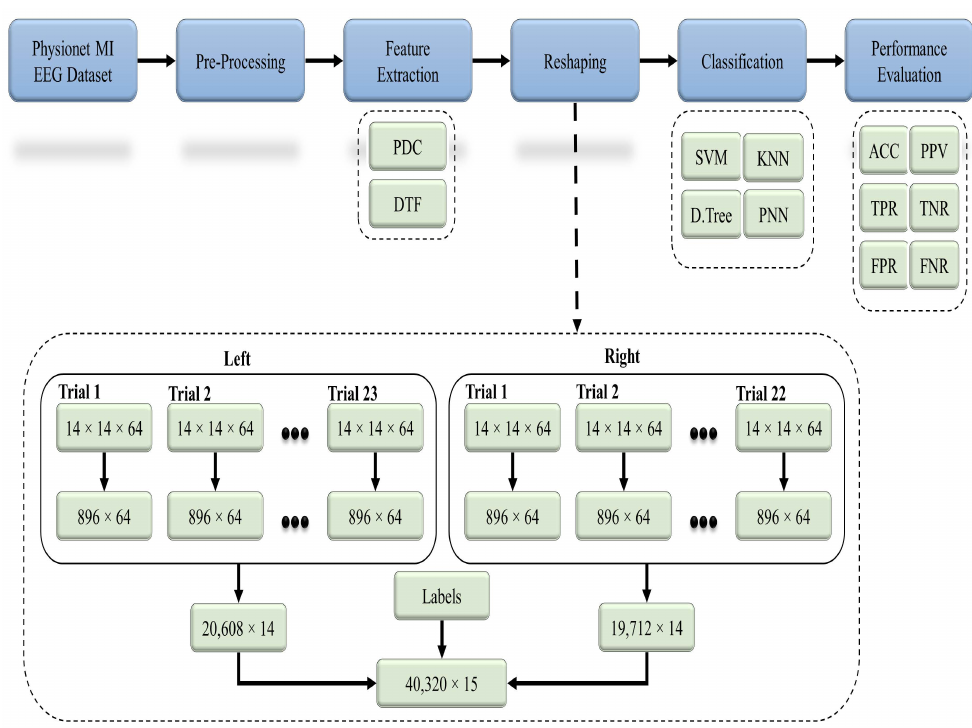
Figure 4. General workflow diagram for the classification of the two-class MI EEG using the effective connectivity matrices with the PDC and